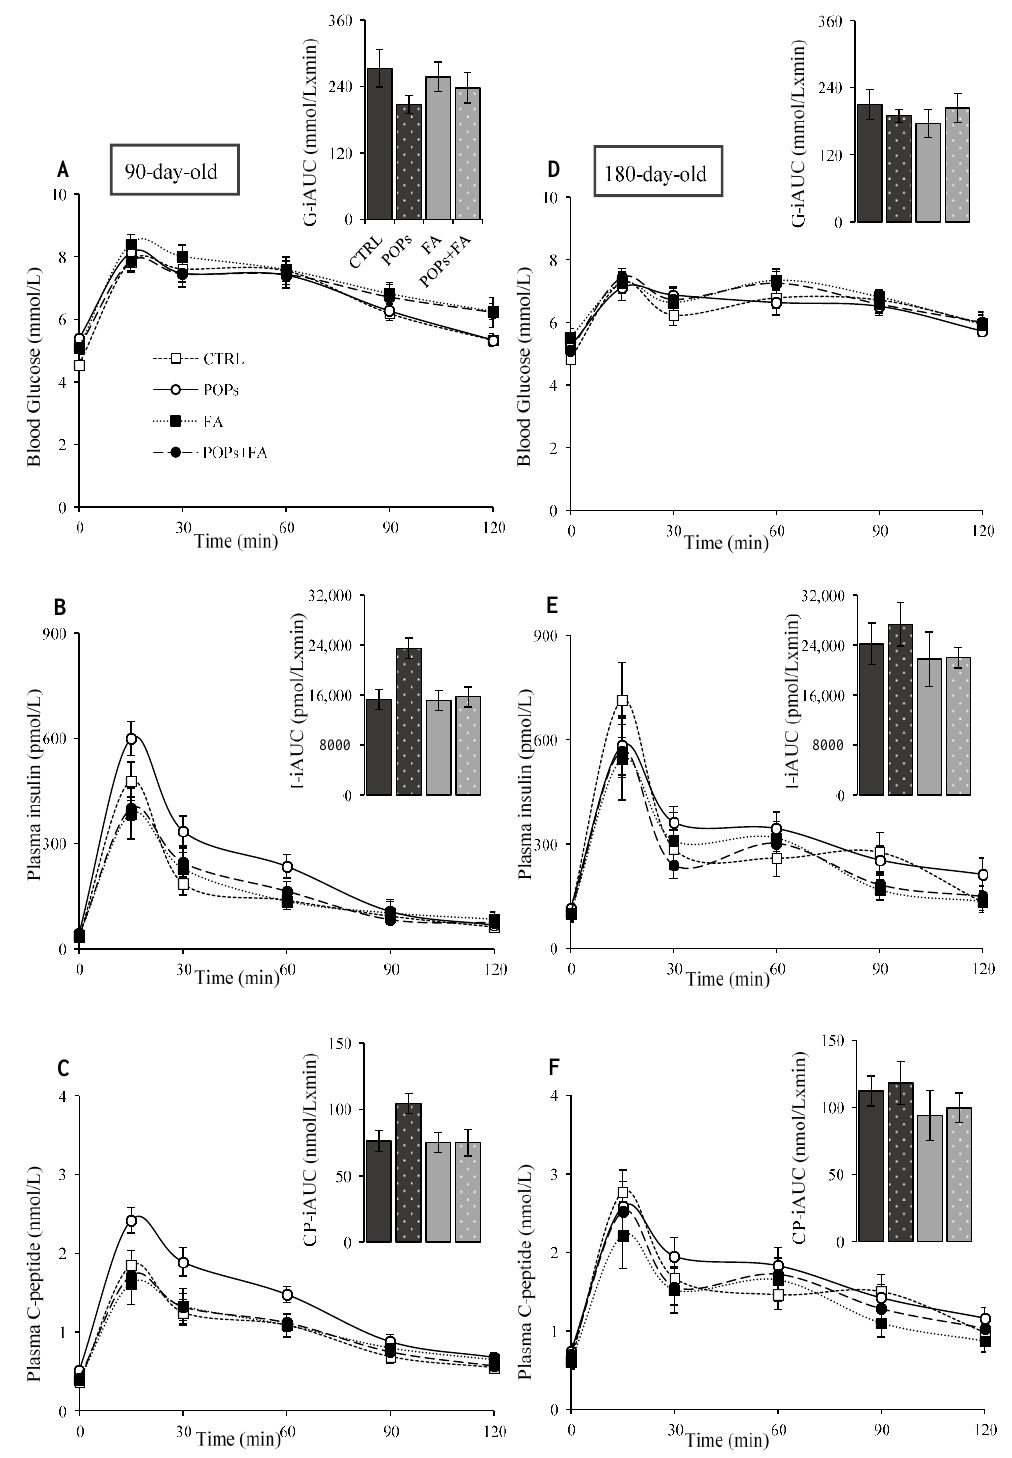
Figure 4. Impact of POP exposure and/or FA supplementation of F0 female rats on blood glucose, plasma insulin and C-peptide during a glucose tolerance test in F2 male rats aged 90 days ( A – C ) and 180 days ( D – F ). The histogram shows IAUC values. Results are expressed as mean ± SEM (n = 9 or 10). Two-way ANOVA with repeated measurements was used to compare time points within groups. ANOVA for a 2 × 2 factorial experiment was used to analyze the POP and FA main effects and the POPs*FA interaction.